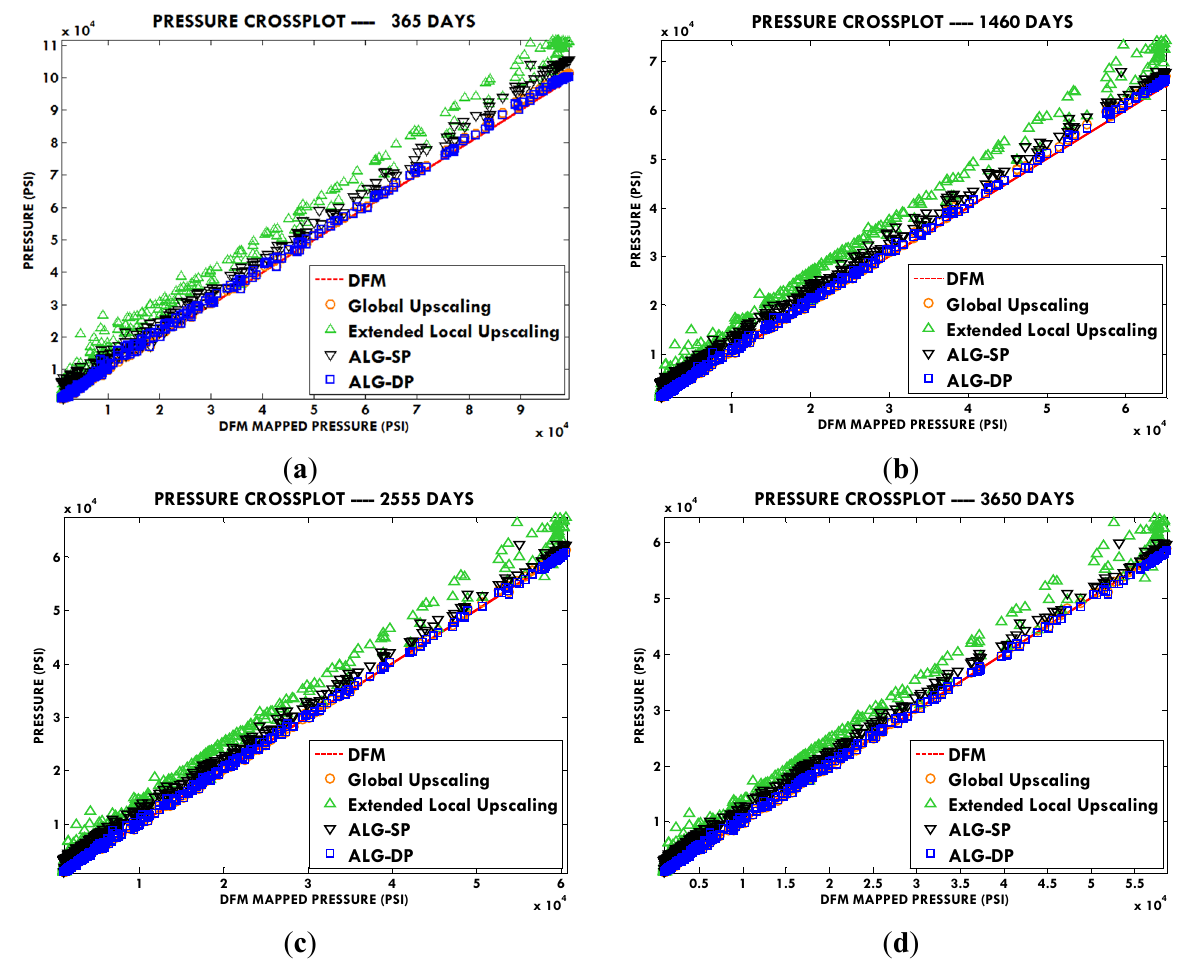
Figure 7. Pressure cross plot for case 1 at ( a ) 365 days; ( b ) 1460 days; ( c ) 2555 days; ( d ) 3650 days.